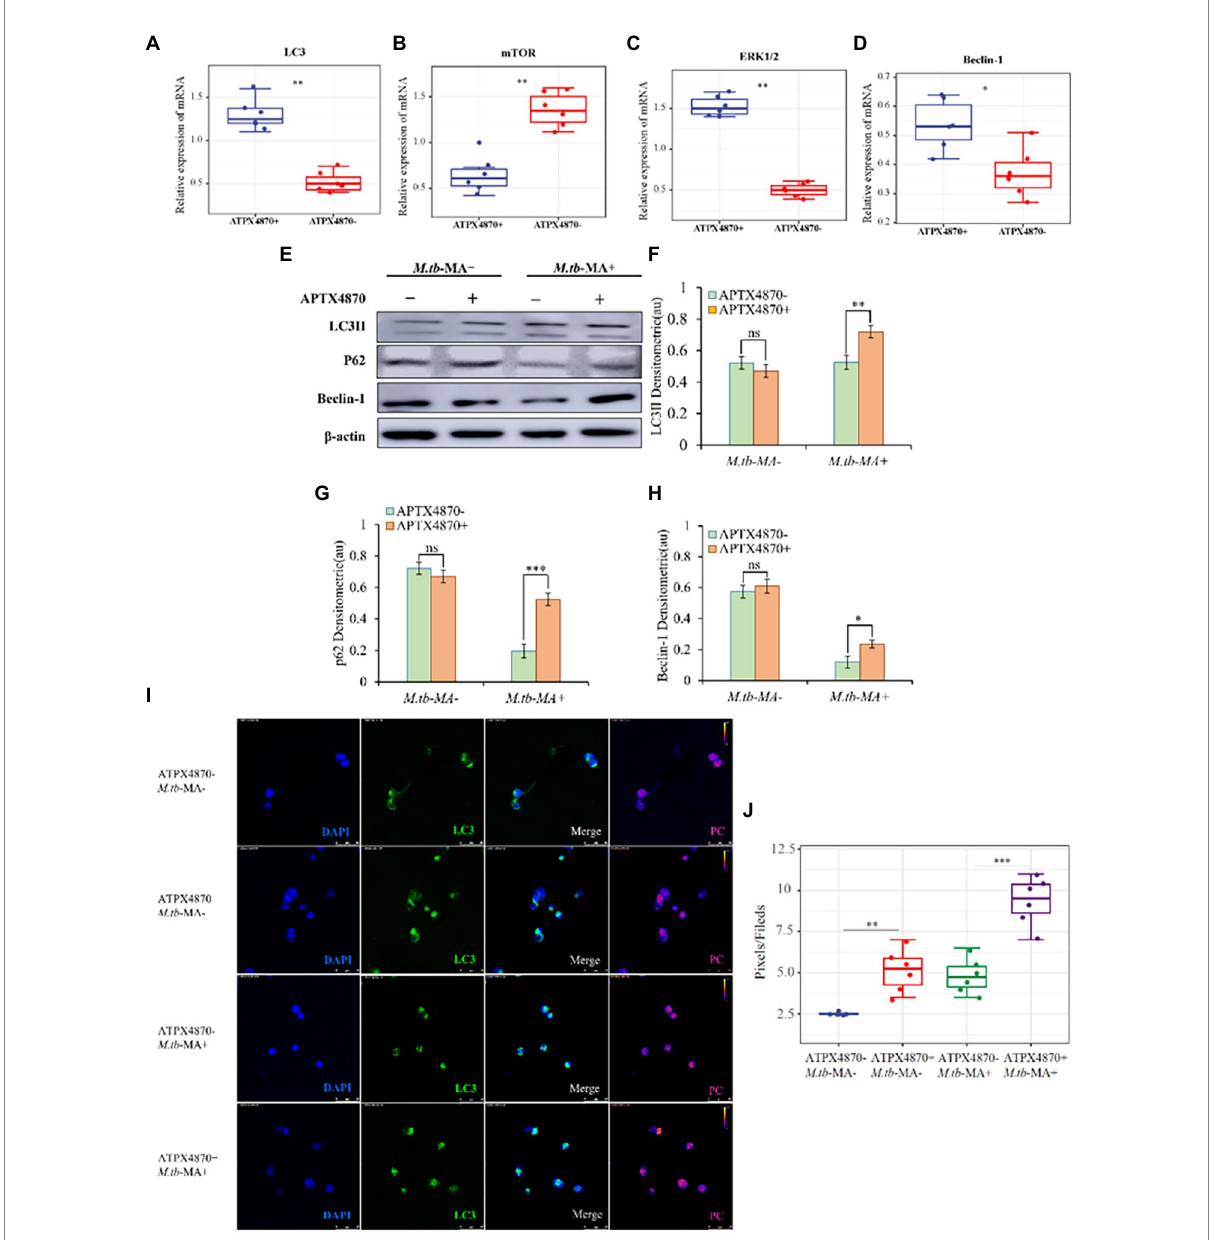
FIGURE 5 APTX4870 could reduce the inhibiting of autophagy induced by M.tb -MA. (A–D) Effects of APTX4870 co-treated induced activation of autophagy cytokines activation was measured by q-PCR. Change of secreted cytokines content of (A) LC3, (B) mTOR, (C) ERK1/2, (D) Beclin-1 ( n = 6). Data were presented as mean ± SD, * p < 0.05; ** 0.01 < p < 0.05: APTX4870+ M.tb -MA vs. M.tb -MA. (E–H) Immunoblots of LC3, mTOR, and Beclin-1 in different groups. Semi-quantitative expression of indicated proteins by optical densitometry assay using ImageJ Software version 1.46 ( n = 3). Data were presented as mean ± SD, * p < 0.05; ** 0.01 < p < 0.05; *** p < 0.001: APTX4870+ M.tb -MA vs. M.tb -MA. (I,J) The expression of LC3 was analyzed by immunofluorescence cytochemistry. LC3 is visualized in green and DAPI-stained nuclei in blue. Pseudo-color is used to show the difference in fluorescence intensity. Scale bars: 50 μ m. Fluorescence values were quantitatively analyzed 6 images and boxplots were drawn. Quantitative the expression of LC3 by optical densitometry assay using ImageJ Software version 1.46. Data were presented as mean ± SD, * p < 0.05; ** 0.01 < p < 0.05; *** p < 0.001: APTX4870+ M.tb -MA vs. M.tb